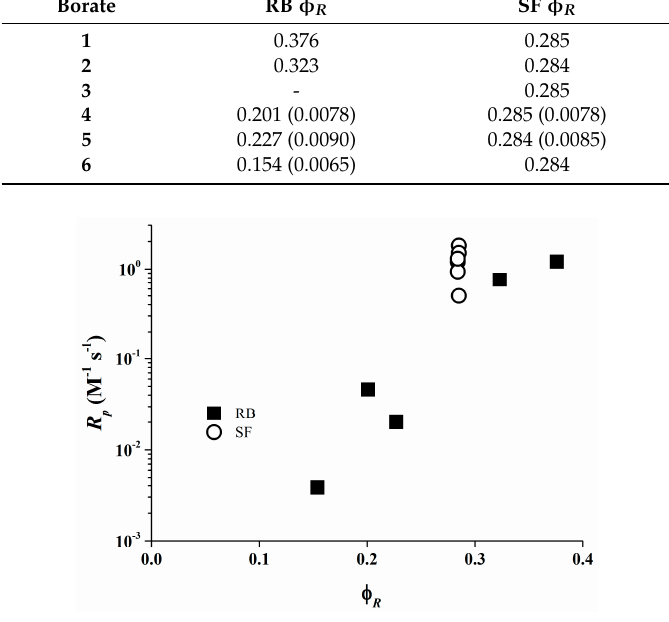
Figure 8. R p versus φ R in the photo-polymerizing resin [35].